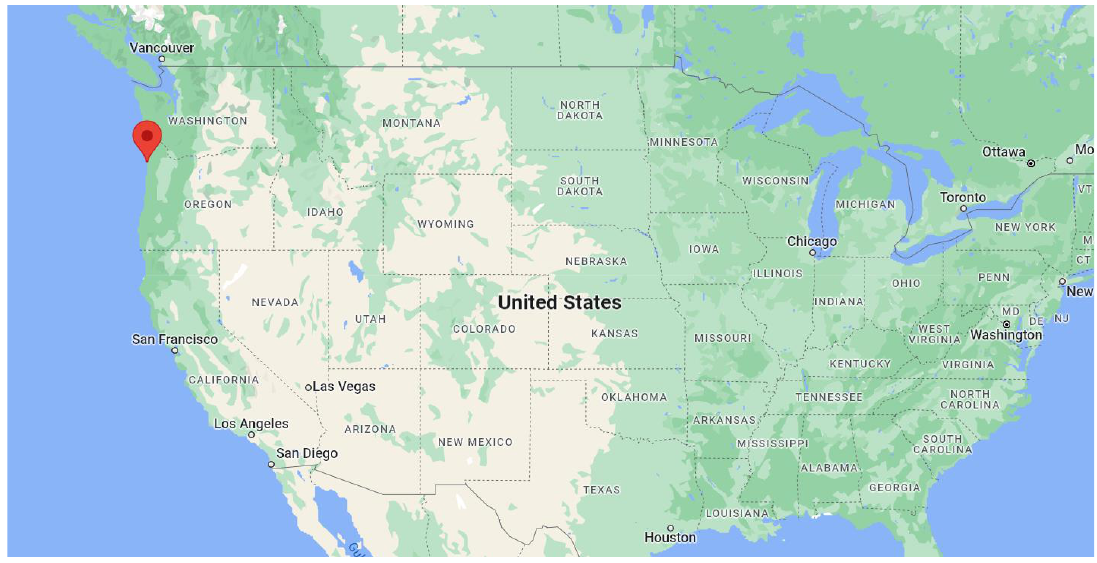
Figure 1. Approximate location of freak wave accident in Tillamook Bay, Oregon (25 January 2007).